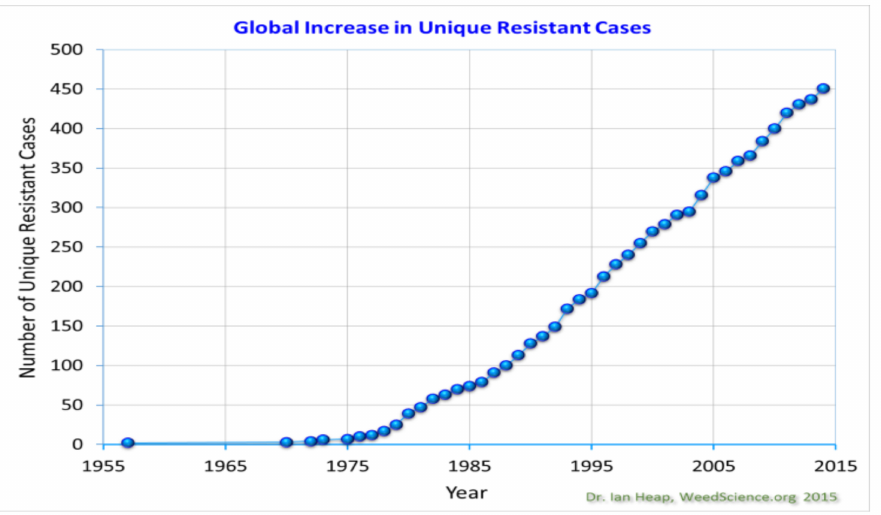
Figure 5. Change in herbicide resistance over time (from Heap